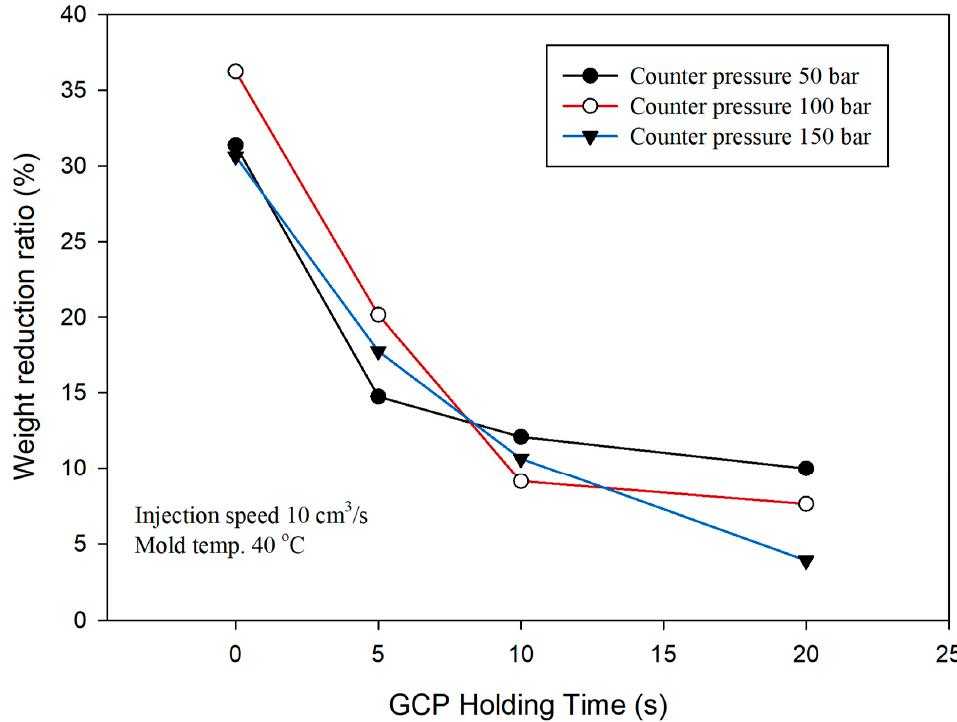
Figure 16. Comparison of weight reduction ratio under various GCP and holding times.